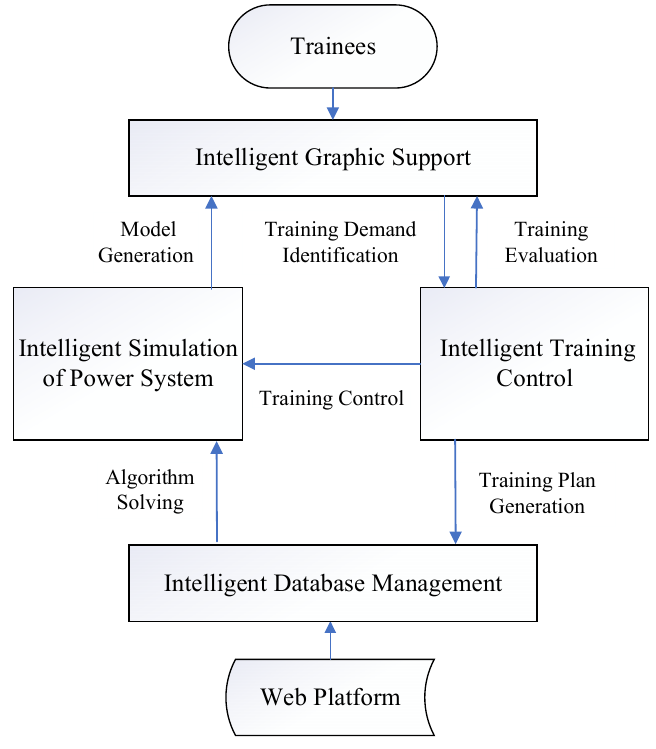
Figure 3. Structure of an IDTS.